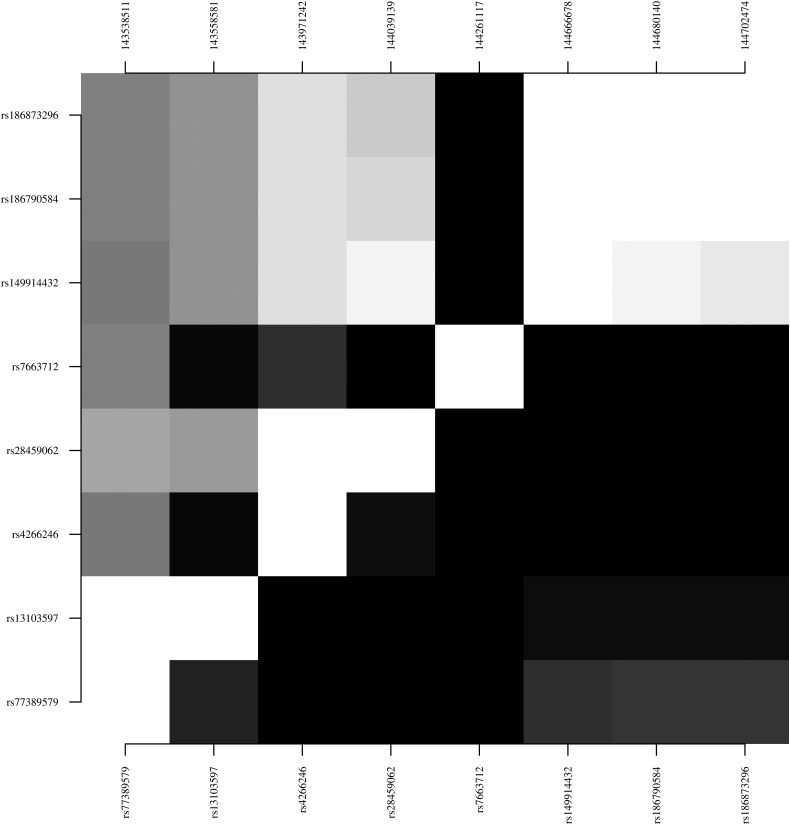
Linkage disequilibrium, Top left, D′; bottom right, r2. Black represents 0; white, 1. A, Single-nucleotide polymorphisms (SNPs) in FREM3 and flanking candidate genes on chromosome 4: rs77389579 and rs13103597 (INPP4B), rs4266246 and rs28459062 (USP38), rs7663712 (GAB1), and rs149914432, rs186790584, and rs186873296 (FREM3). B, SNPs in the DDC and IZKF1 genes on chromosome 7: rs7779749, rs10230385, rs6964823, rs11552046, rs4132601, rs11980407, and rs6944602 (IZKF1) and rs4947535–rs7800827 (DDC).